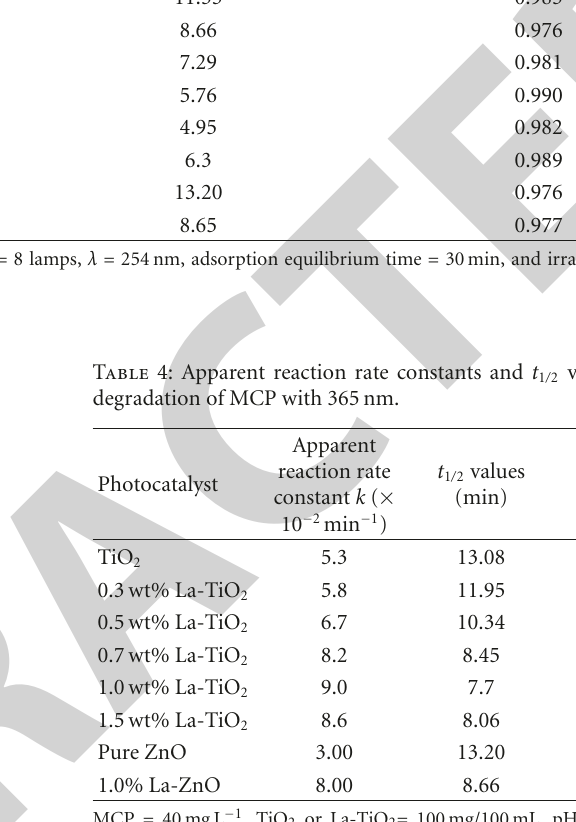
Table 3: Apparent reaction rate constants and t 1 / 2 values for the degradation of MCP with 254 nm. Photocatalyst